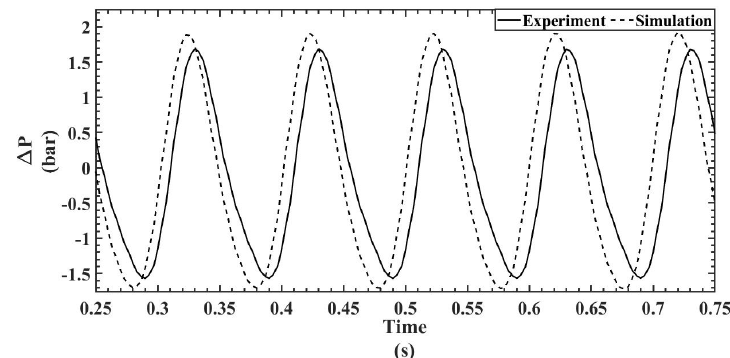
Figure 21. Temporal pressure drop for a 200 mesh regenerator at 600 RPM.